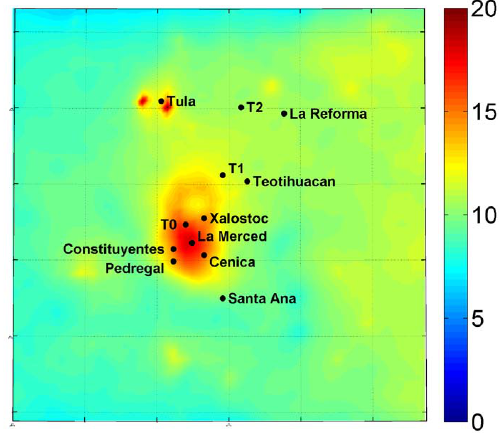
Fig. 2. Predicted average ground level concentrations of PM 1 or- ganic mass (µgm − 3 ) during 4–30 March